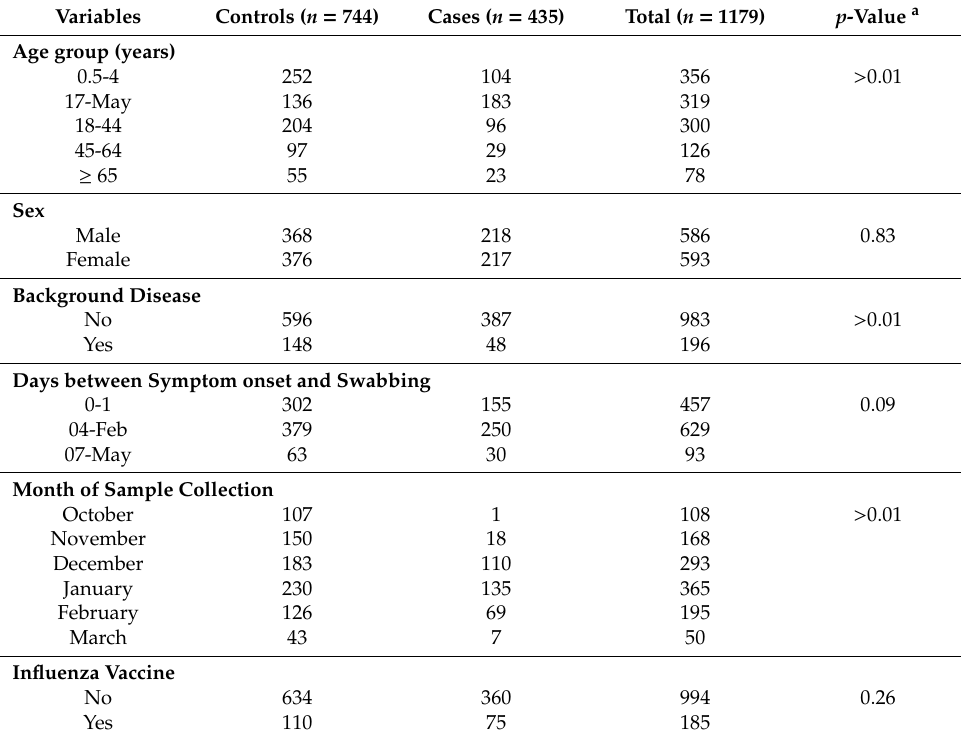
Figure 3. Flowchart of individuals with influenza-like illness presenting at the 2018-2019 sentinel primary care clinics in Israel, with the exclusion of individuals not eligible to be included in the vaccine e ff ectiveness analysis. Asterix symbol (*) denotes the inclusion of four samples coinfected with influenza A (H1N1)pdm09 and influenza B. Table 1. Characteristics of influenza A (H3N2) cases and controls—2018 / 2019